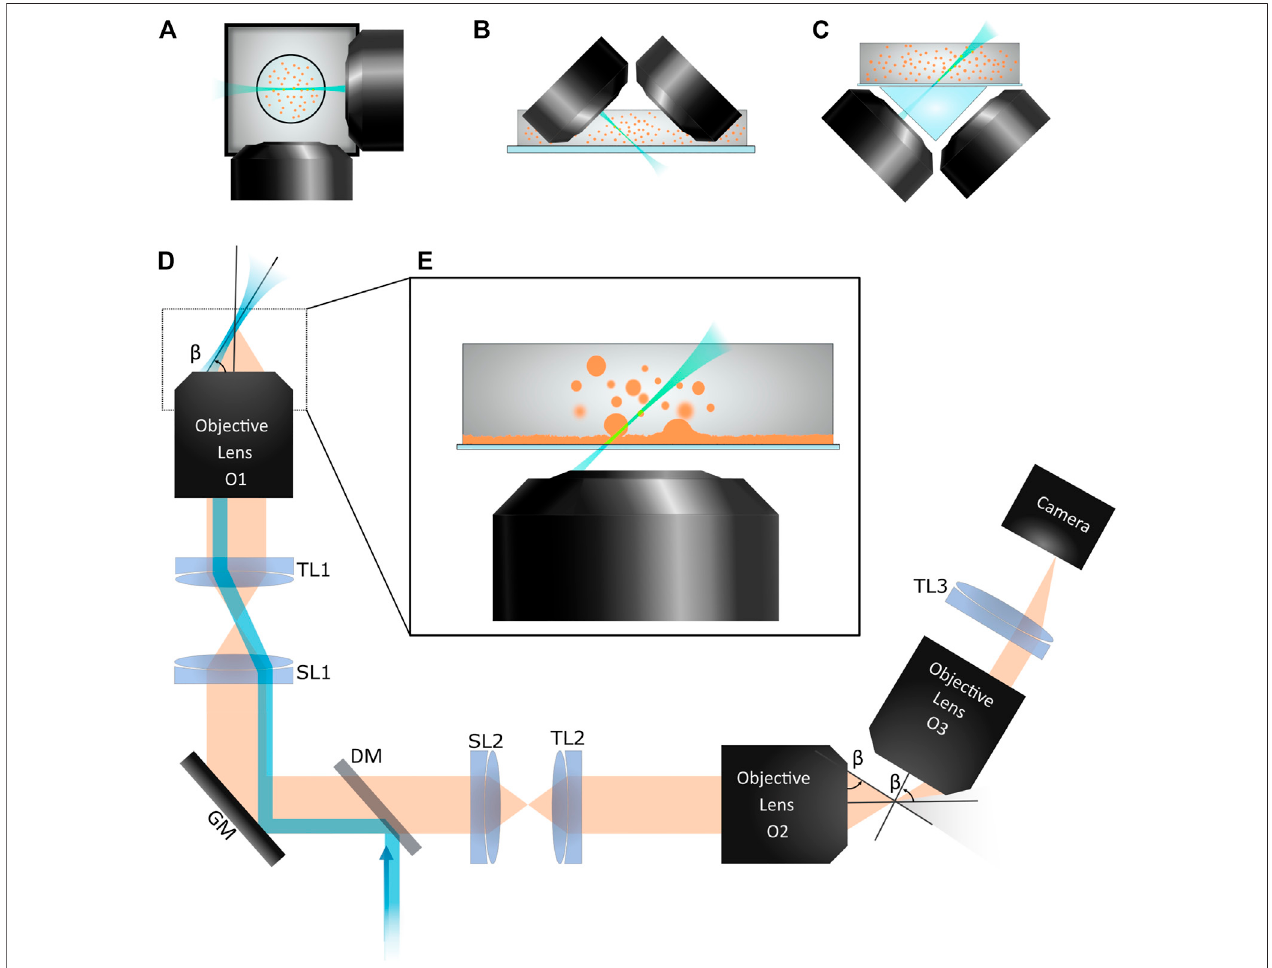
FIGURE1| VariousLSFMcon fi gurationsareshown. (A) Twoorthogonalobjectivelensessurroundthesamplecontainedineitheracapillarytubeorcylinderofgel. (B) AniSPIMsystemusestwoobjectivelensthatmeetthe fl at-bottomedsampleholderat45 ° .Thiscon fi gurationisidealforimagingintoanopenpetridish. (C) Open-top LSFMcon fi gurations imageacrossaplanarsampleholder frombelow,similartoaninverted microscope.Sinceimagingisdoneacrossatitledinterface,awaterprismis used tominimize aberrations. (D) Inoblique planemicroscopy,thesheet ofexcitationlightleaves theprimary objective lens, O1,at anangle β relativetothe frontof thelens.Fluorescenceemission iscollectedbyO1.Thesecondobjectivelens,O2,demagni fi estheimageand thethirdobjectivelens,O3,imagesthetitled planeonthe camera. TL1, TL2, and TL3: tube lenses. SL1 and SL2: scan lenses. GM: galvo mirror. DM: dichroic mirror. In our setup, O1 is a 40 × 1.15NA water immersion lens (Olympus);O2,40 × 0.95NAlens(Olympus);O3,50 × 0.75NAlens(Mitutoyo). (E) Aclose-upofO1withasampleisshown.WeusethisOPMsystemtoimageacolloid- polymersystemwhichphaseseparatesintocoexistingcolloid-rich(liquid)andcolloid-poor(gas)phases.Weobservedropletscoalescewiththebulkliquidphaseaswell as fl uctuations of the planar liquid-gas